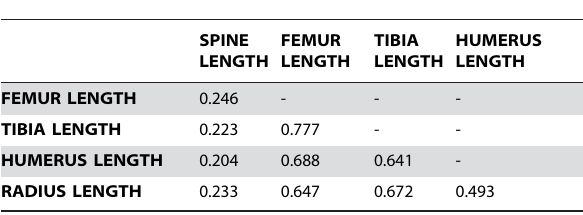
Table 2. Correlation matrix between